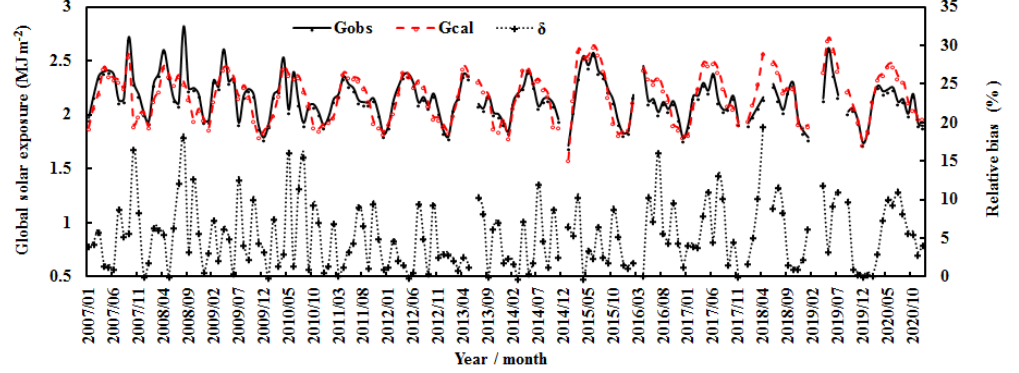
Figure 4. Monthly global solar exposure (calculated and observed) (G) and relative biases ( δ ) at the